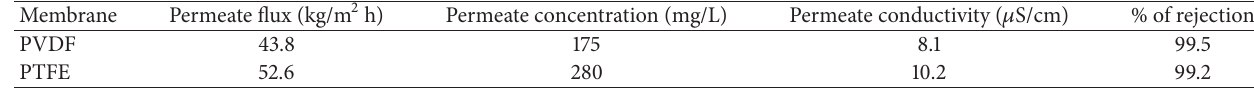
Table 6: Comparison of the PVDF and PTFE membranes at 65 ∘ C, 110.2 (L/h), and 97 kPa for 35 g/L.